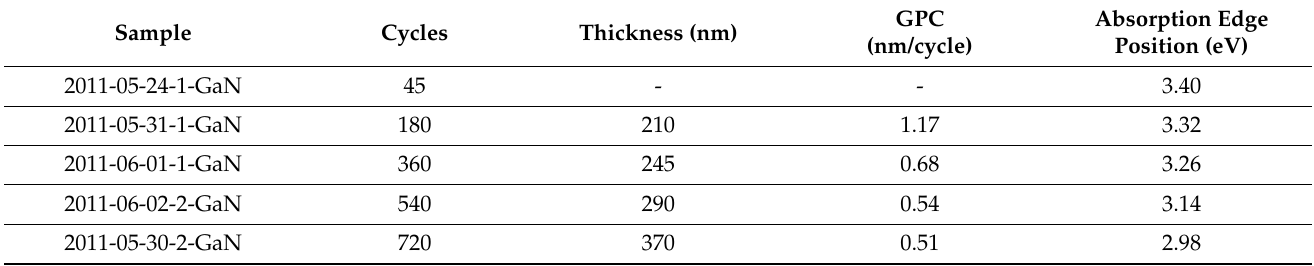
Table 1. Table showing film thickness and absorption edge data for gallium-rich growth series.